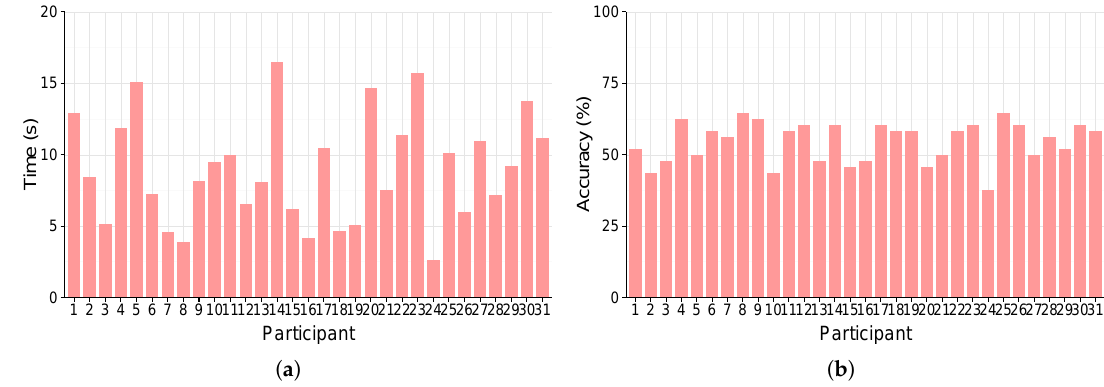
Figure 11. Individual performance. ( a ) Individual completion time; ( b ) Individual accuracy.